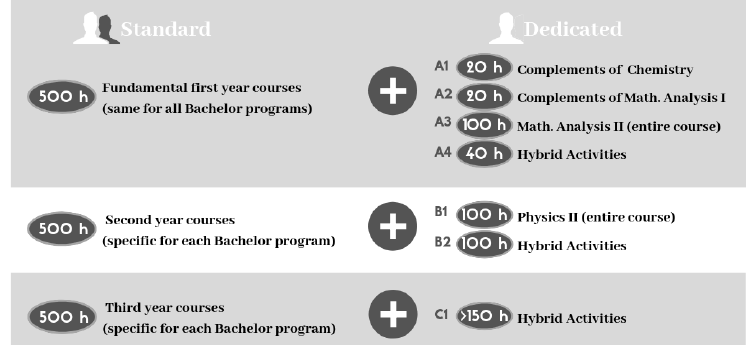
Fig. 2. The detailed structure of the